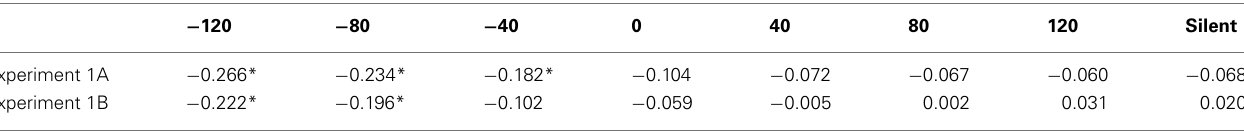
Table 1 | Perceived offset position in Experiment 1 in visual